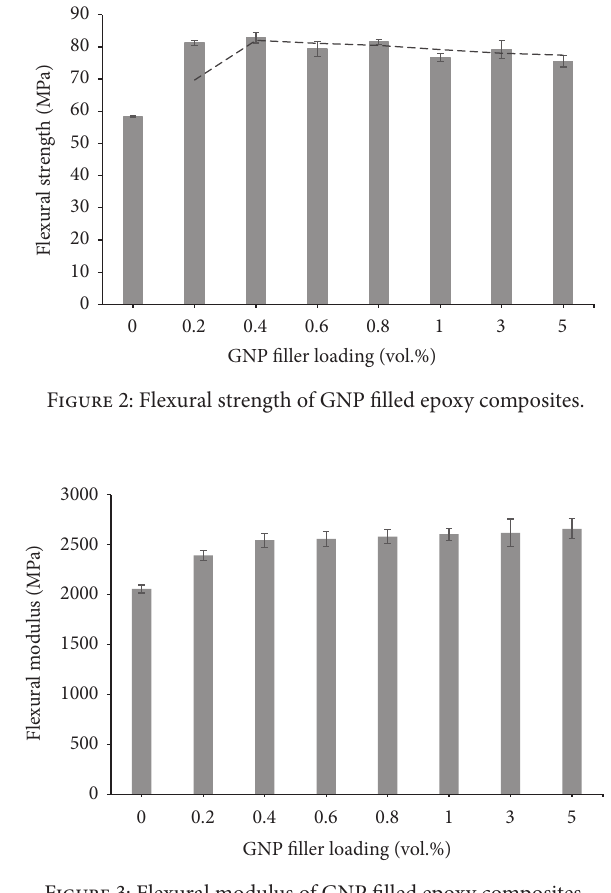
Figure 3: Flexural modulus of GNP filled epoxy composites.